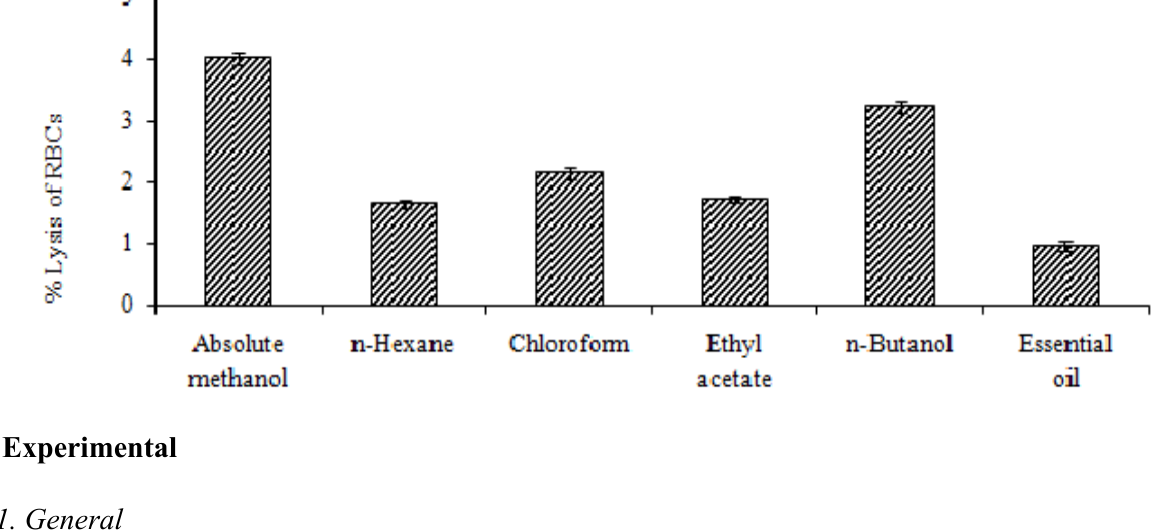
Figure 4. Cytotoxicity assay by heamolytic activity by extract, fractions and essential